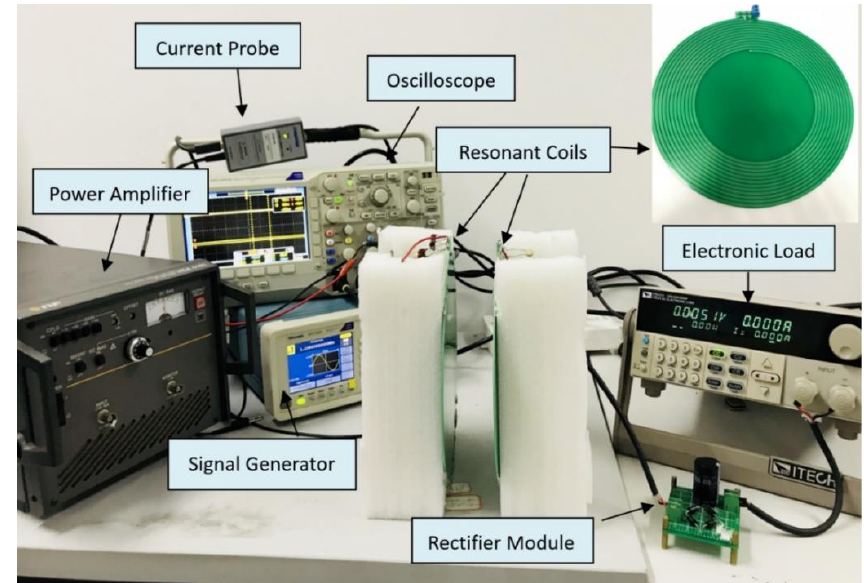
Figure 10. The arrangement of the experimental system.